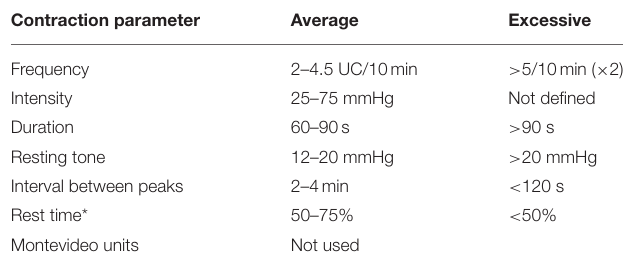
TABLE 2 | Definition of excessive uterine